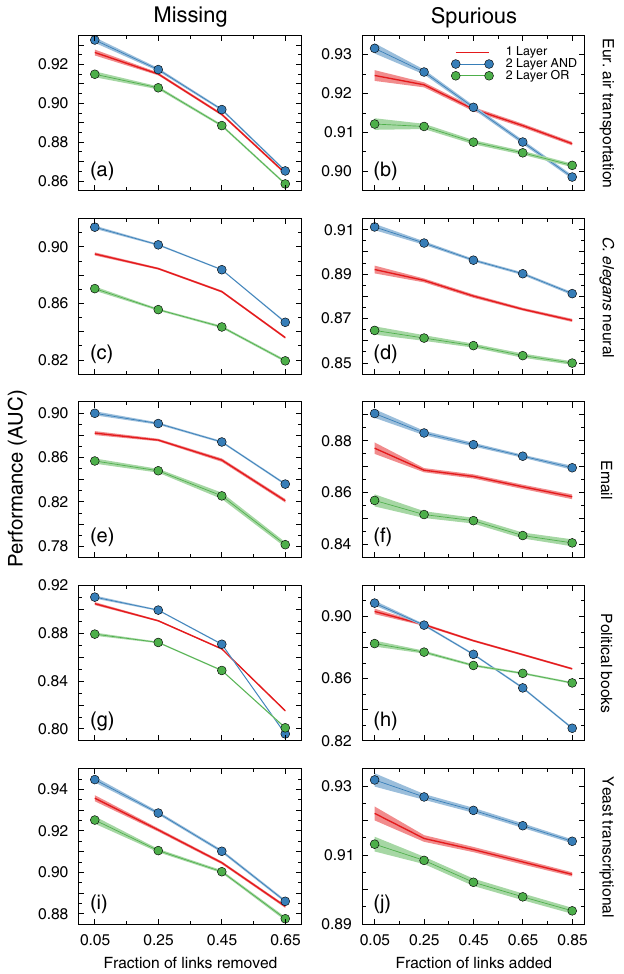
FIG. 5. Performance of missing and spurious link identification on real aggregated networks. We proceed as in Fig. 4 to compare the performance of the different approaches at detecting missing links (a),(c),(e),(g),(i) and spurious links (b),(d),(f),(h),(j). We show results for five real-world networks (see Supplemental Material for results on other networks [48]): (a),(b) the air transportation network in Eastern Europe [51], (c),(d) the neural network of C. elegans [52], (e),(f) the Email network within an organization [53], (g),(h) the network of books about U.S. politics in 2004 elections [54], and (i),(j) the transcriptional regulation network of yeast S. cerevisiae [55]. Red lines represent the AUC 1 L obtained with single-layer SBMs, blue circles correspond to AND two-layer SBMs, and green circles to OR two-layer SBMs.